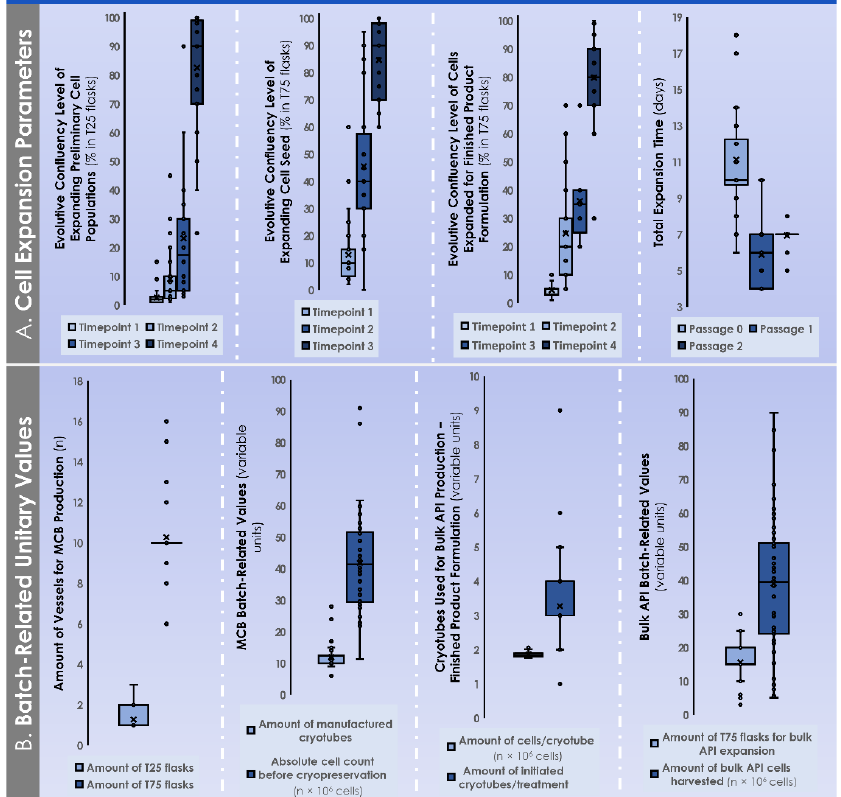
Figure 5. Original data from GMP manufacturing records relative to primary HAC ( n = 47 cell